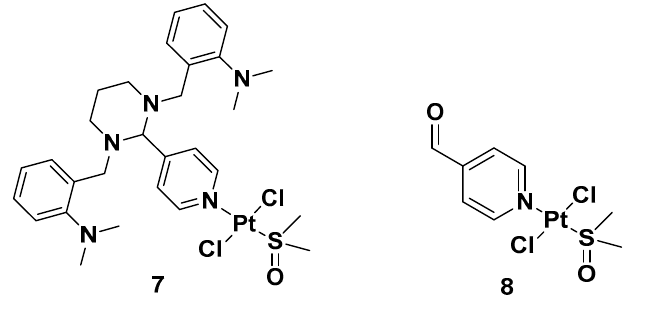
Figure 6. Complexes 7 and 8 .